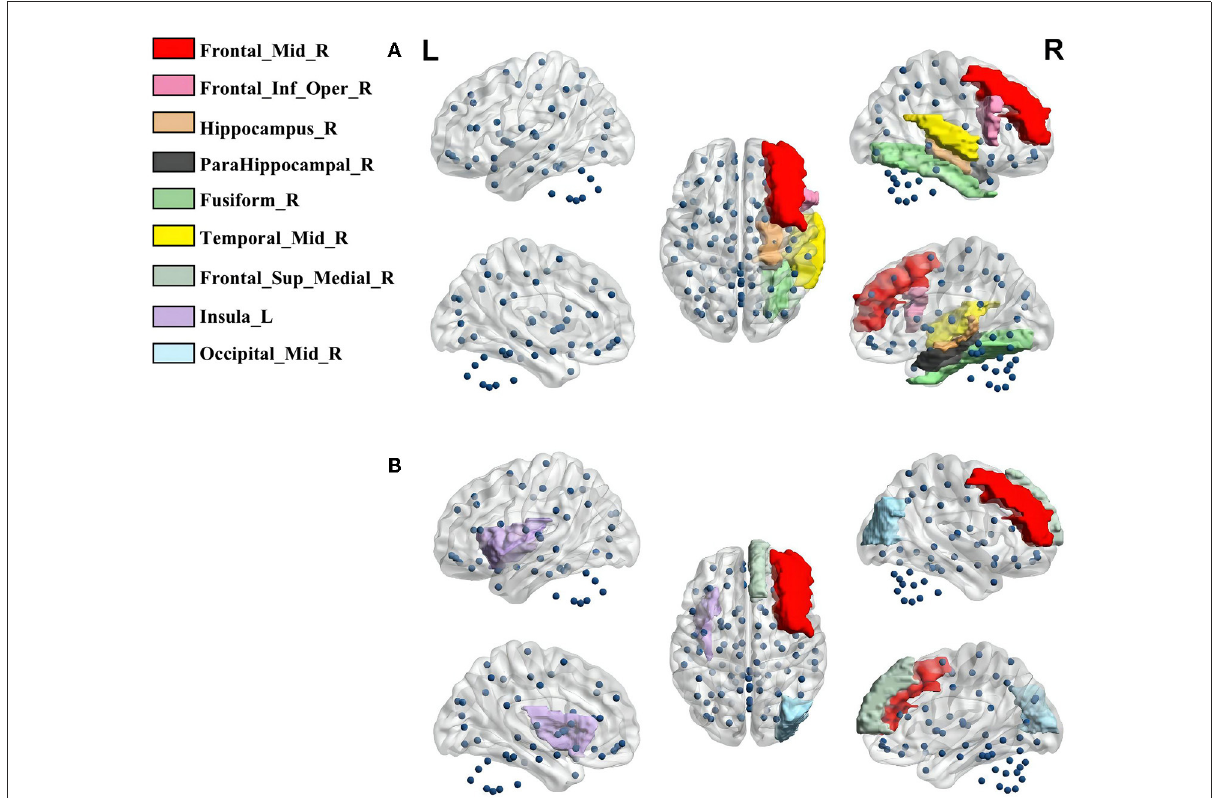
indicate that passengers are more likely to experience anxiety when they are in an uncomfortable